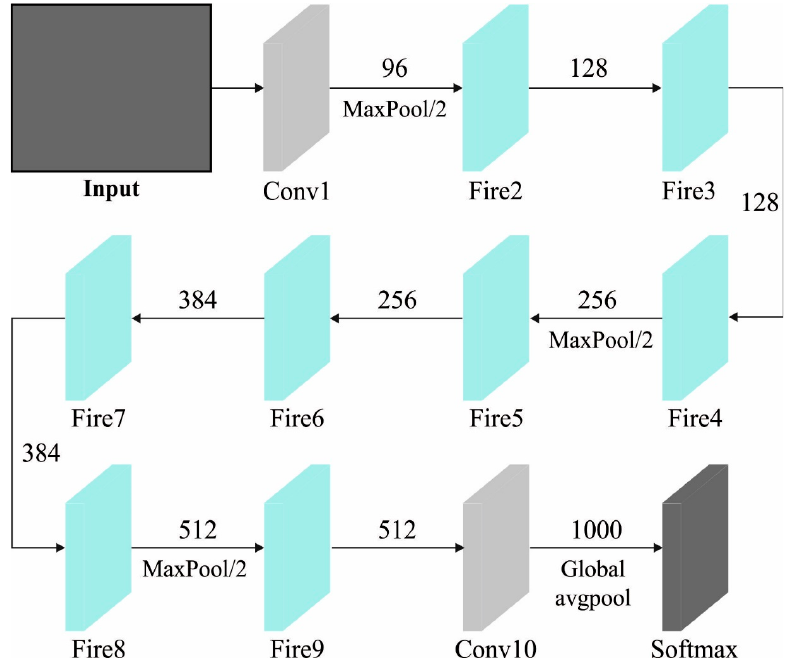
Figure 3. Architecture of Faster